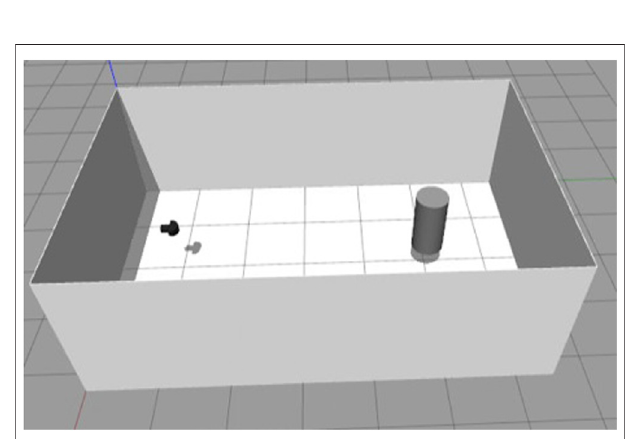
FIGURE 6 | A multibeam echosounder set in side the square sonartank with a cylinder target.